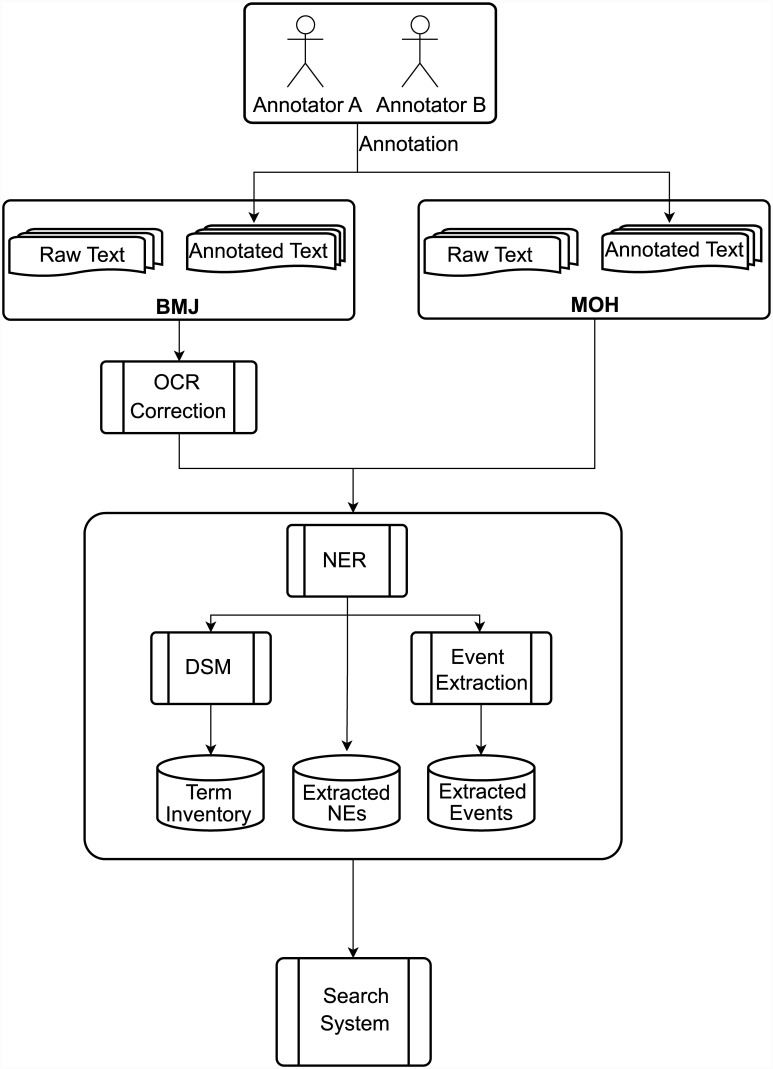
Overview of work.